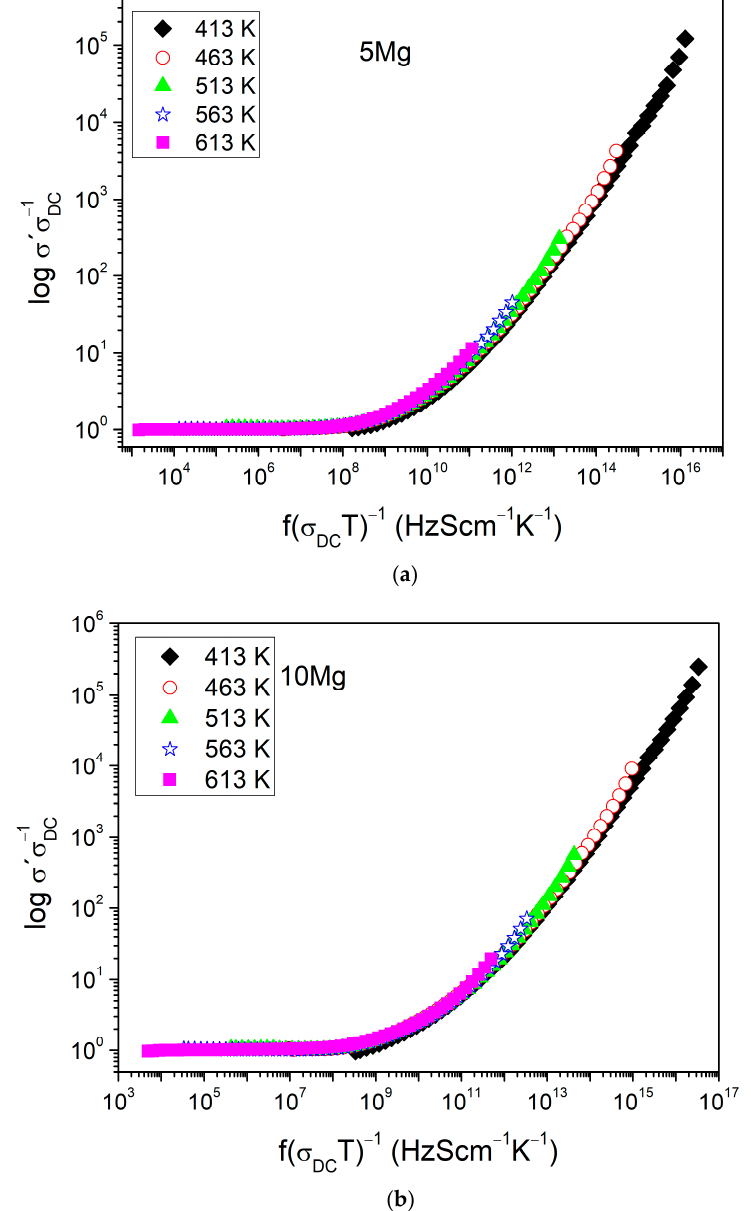
Figure 5. Master curves of samples: ( a ) 5Mg and ( b ) 10Mg.